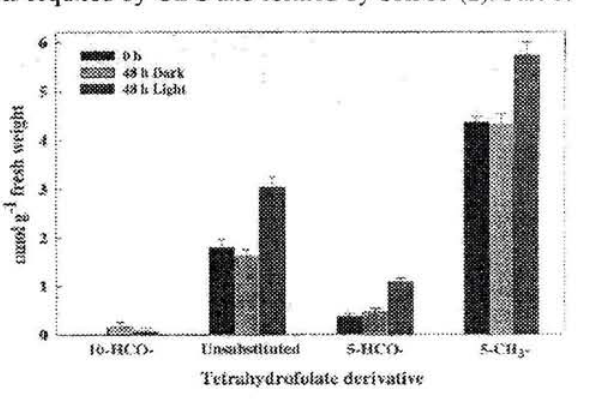
Figure 4. Distribution of individual folates in whole- leaf extracts. Extracts of etiolated and greening leaves were subjected to HPLC and the column effluent was assay for folate using L. rhamnosus. Data are expres- sed as means ± SEM, η —